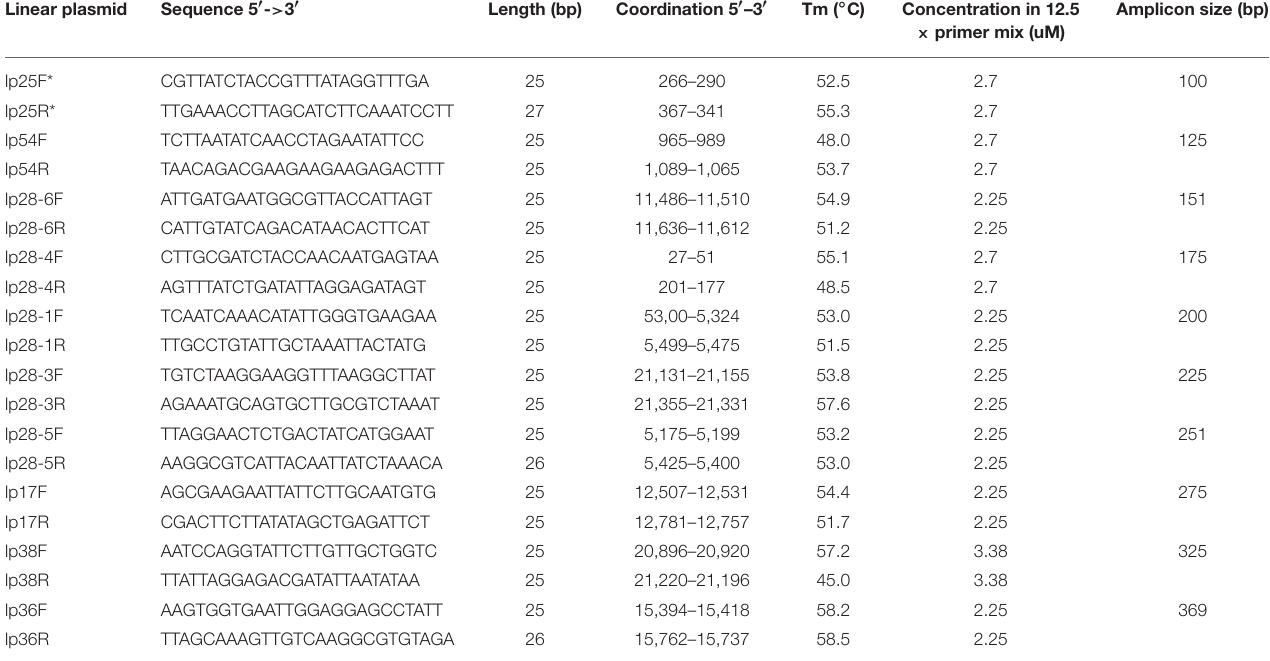
* The primer sequences for lp25 were based on bptA gene sequence.